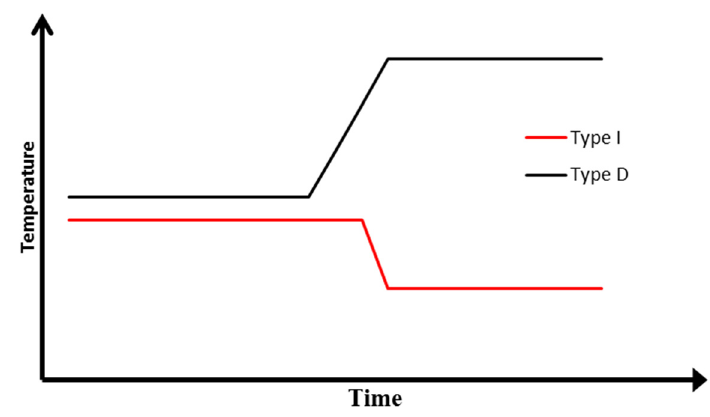
Figure 11. Ideal temperature–time curves of crack type I and type D.